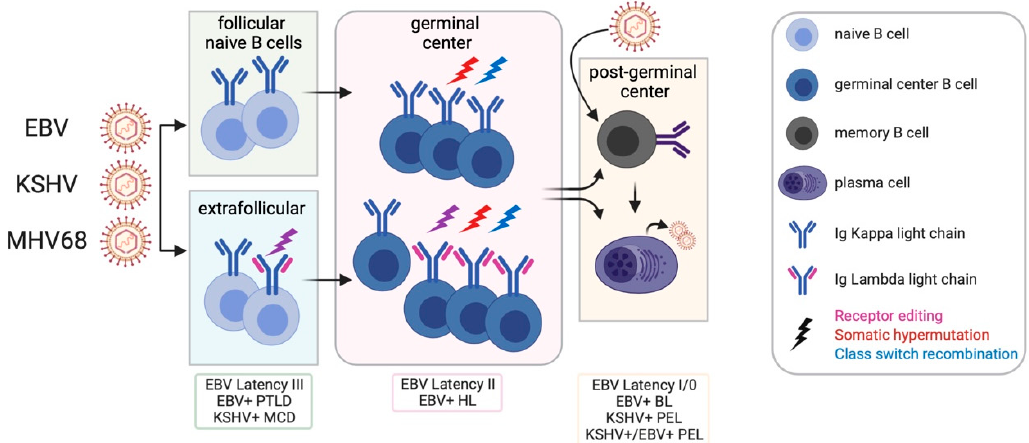
Figure 1. EBV, KSHV, and MHV68 are B cell-tropic members of the GHV that subvert the B cell di ff erentiation processes in which they participate. GHVs infect naïve and extrafollicular B cells. Infected B cells enter the germinal center with a BCR repertoire that is distinct from the uninfected GC B cells. Infected B cells undergo somatic hypermutation and class-switch recombination, while undergoing proliferative expansion and likely evading typical selective pressures. In addition, B cells infected with KSHV and MHV68 undergo receptor editing. GHVs exit the GC as an isotype class-switched B cell or a PC. Direct infection of post-GC memory B cells is a potential route to the class-switched memory compartment. Plasma cell di ff erentiation drives GHV reactivation. Created with BioRender.com.